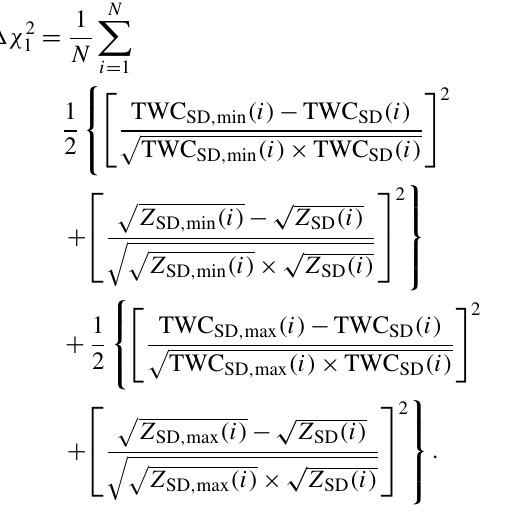
,(cid:49)χ 2 ,(cid:49)χ 2 ) . The χ 2 characterizes the min 1 2 min 1